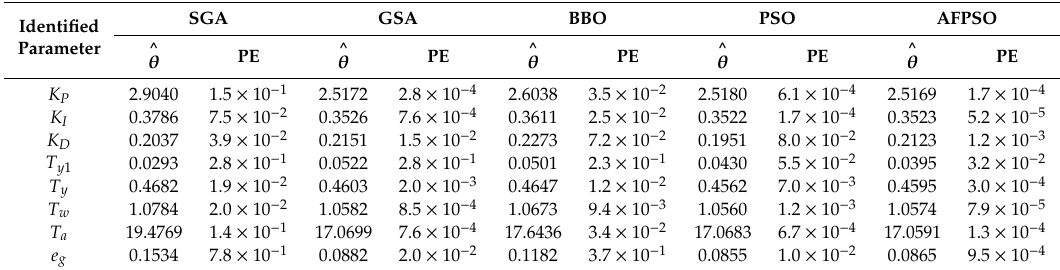
Table 7. Average estimated value and parameter error obtained by different algorithms in 30 tests (load condition).